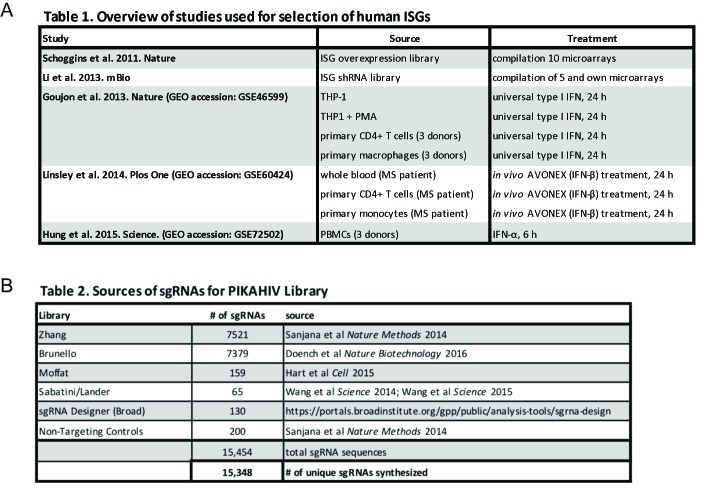
PIKAHIV ISG library gene and sgRNA selection.(A) ISG study, source and treatment conditions for ISGs selected for inclusion in the PIKAHIV library. (B) Sources for sgRNA sequences included in the PIKAHIV library.